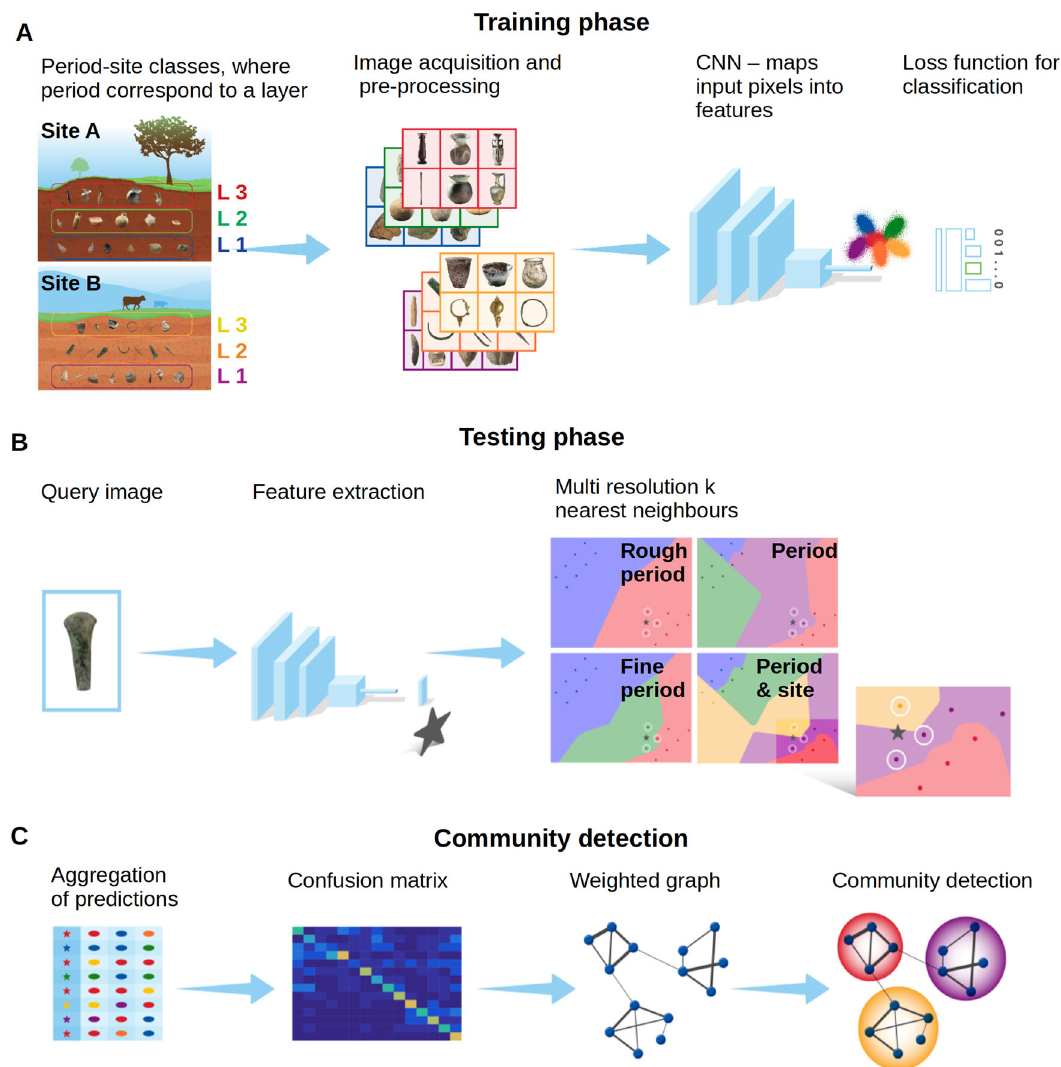
Fig. 1 A schematic representation of the machine learning-based work fl ow. A The training phase: a dataset of images of archaeological artefacts were grouped according to period and site, pre-processed, and used to train a Convolutional Neural Network (CNN). B The testing phase: the trained CNN was used to extract features from a query image and predict its class by identifying k -nearest neighbours in the training set. C Community detection: validation set predictions are aggregated in a confusion matrix that is later transformed into a weighted graph and fed to a community detection